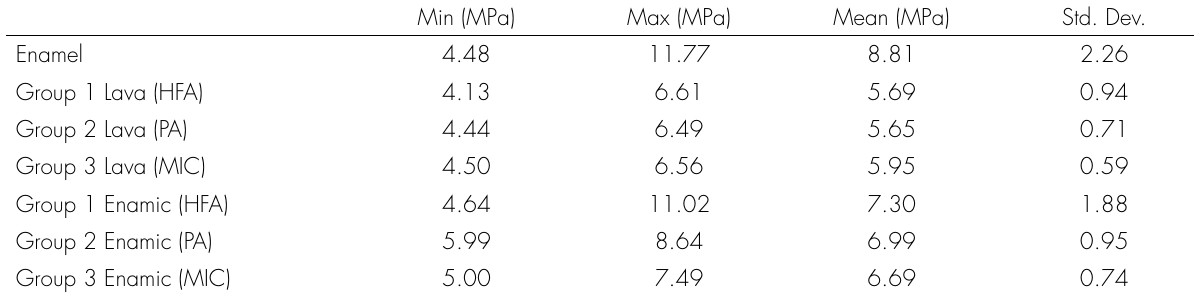
Table I. Minimum, maximum, and mean values for each test group.